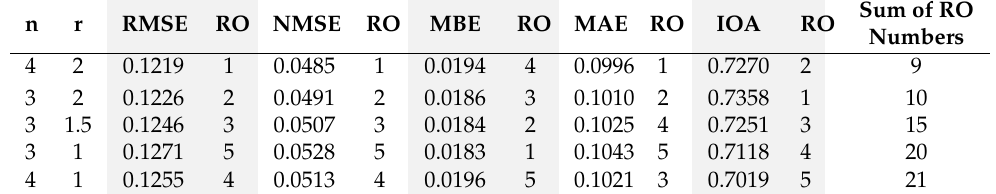
Table 4. The calculated statistical metrics for the evaluated IDW interpolators for chla , the ranking order of each interpolator and the sum of the ranking order numbers.